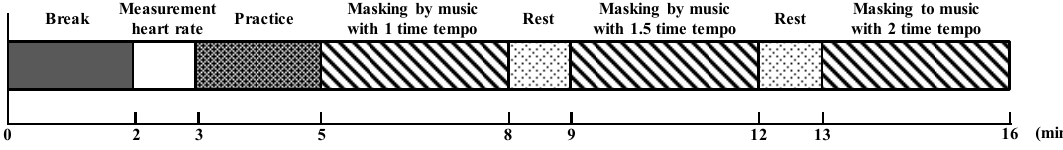
Figure 12. The experimental flow about quantitative evaluation of ride comfort using driving condition.